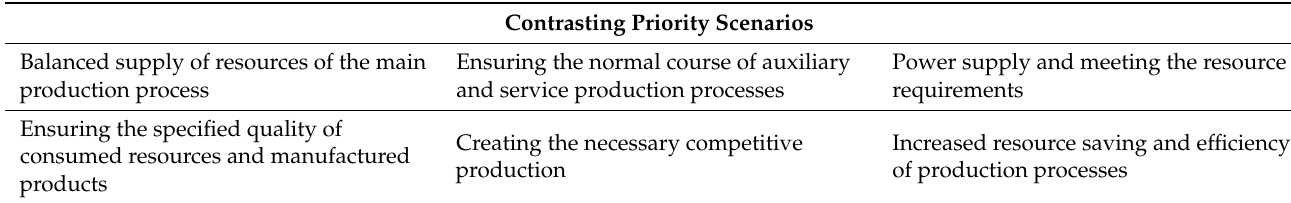
Table 3. Main results obtained at the “Contrasting Priority Scenarios” level.